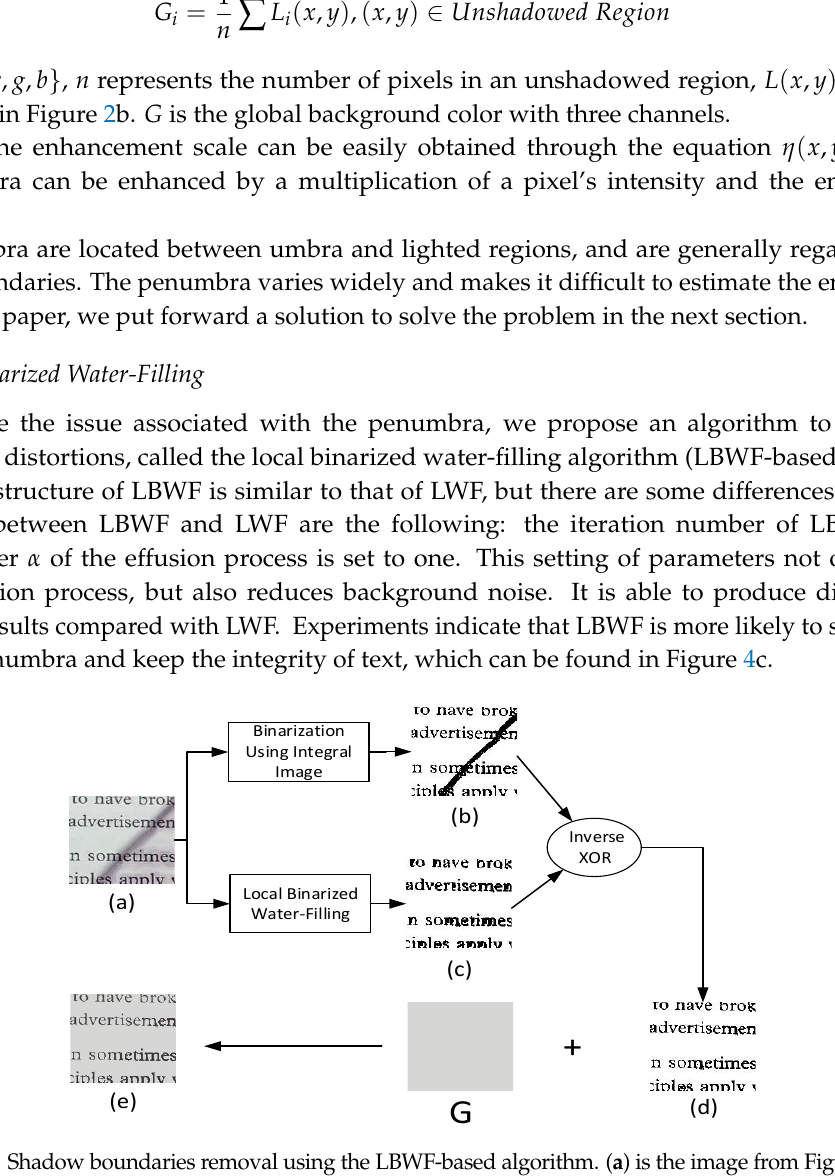
Figure 4. Shadow boundaries removal using the LBWF-based algorithm. ( a ) is the image from Figure 2b,d the binarization result of an adaptive thresholding method [20], ( c ) the binarization result of the proposed LBWF, ( d ) the inverse result of the XOR operation between the images ( b ) and the image ( c ), ( e ) the final result of shadow removal by combing the image ( d ) and the global background color G , which includes three channels and comes from Equation